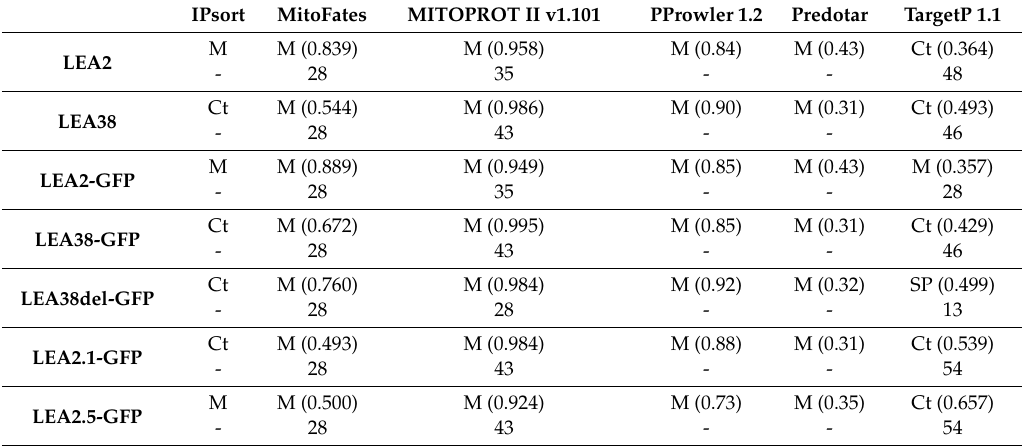
Table 2. Subcellular localisation and pre-sequence length predicted for LEA2, LEA38, and related mutated proteins. Six programs were used to predict the protein subcellular localisation of the indicated proteins (M, mitochondria; Ct, chloroplast; SP, secretory pathway). When available, probability is indicated in parentheses. The length of the predicted targeting sequence is indicated below each prediction for the three programs providing this analysis. IPsort MitoFates MITOPROT II v1.101 PProwler